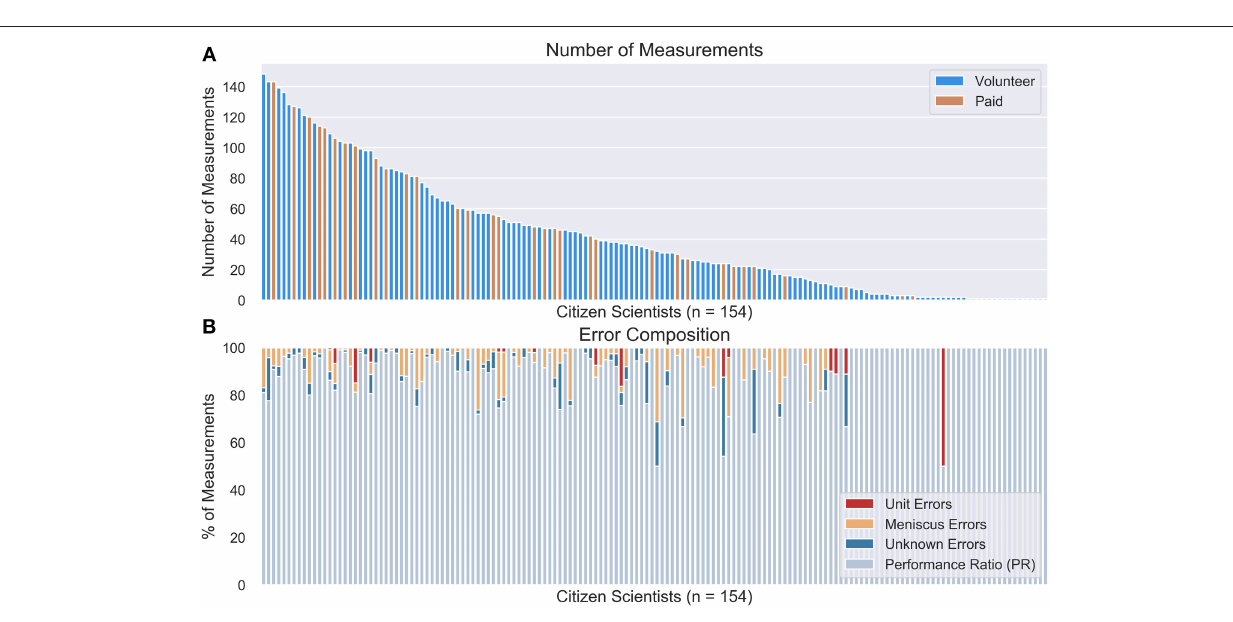
FIGURE 10 | Summary of (A) the number of measurements collected from May through September with volunteer and paid citizen scientists distinguished and (B) the corresponding error composition for all 154 citizen scientists. Citizen scientists sorted in descending order by their total number of measurements. Performance ratio (PR) becomes less informative as the total number of measurements for each citizen scientist decreases, especially at or below